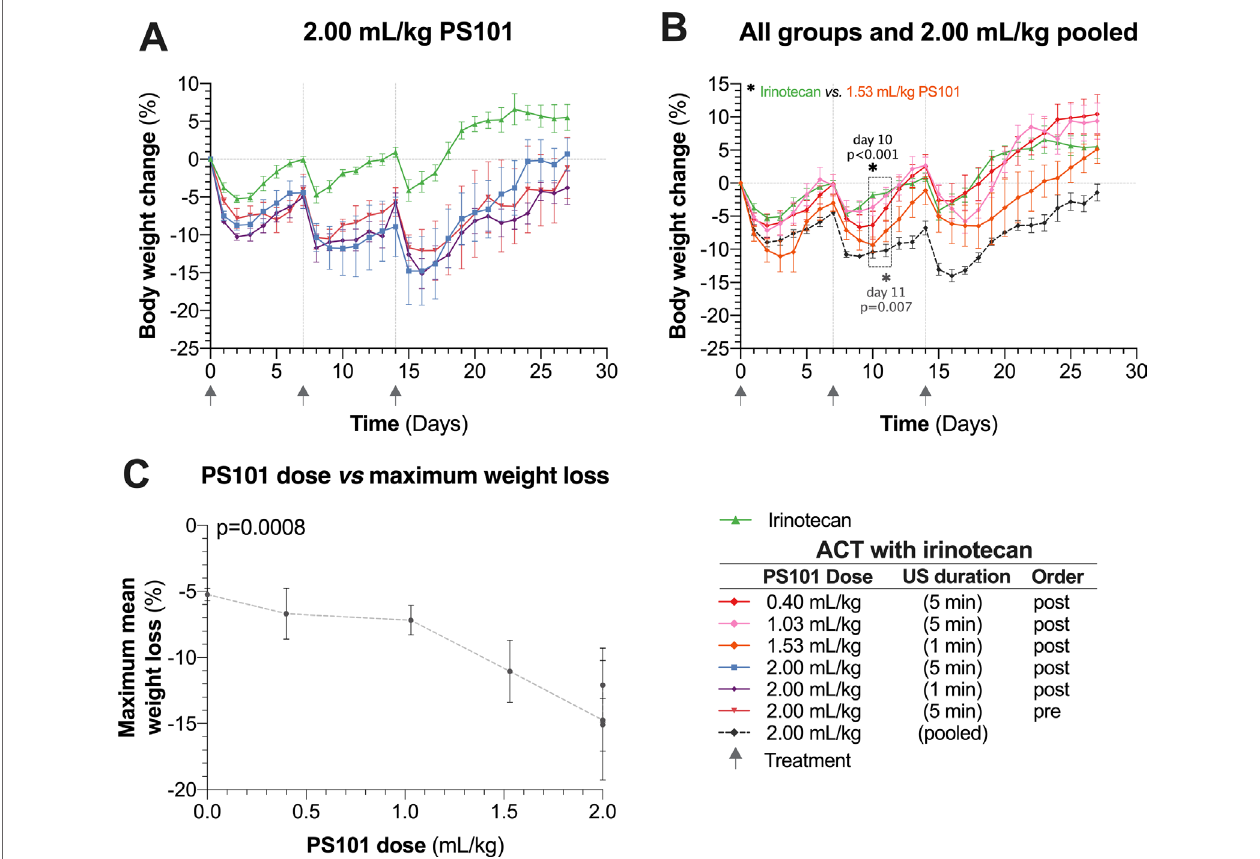
FIgURe 2 | Normalized mouse body weight as a function of time. (Panel A ) shows the results for irinotecan alone and ACT with irinotecan for the highest dose of PS101 (2.00 ml/kg). Mouse body weight was significantly lower in all the 2.00 ml/kg PS101 groups for the entire 27 days (p = 0.035, ANOVA). (Panel B ) pools the 2.00 ml/kg groups and compares the weight change against all other ACT with irinotecan groups. Increasing the PS101 dose increased the loss in body weight. The three grey arrows on the time axis indicate the treatment days. (Panel C ) compares the maximum body weight loss to the PS101 dose. The correlation was significant (p =